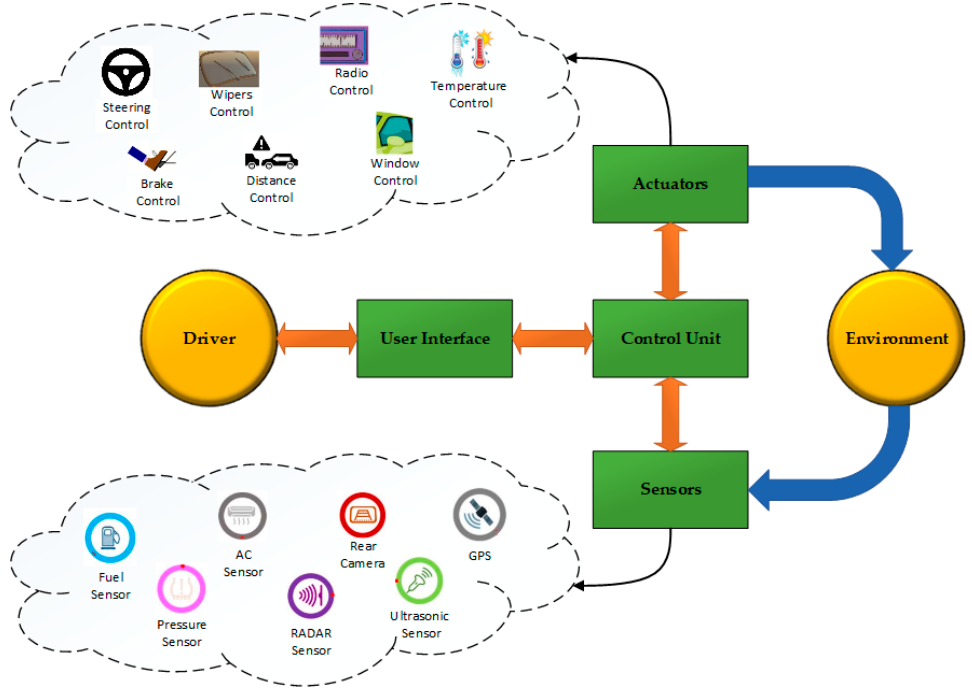
Figure 1. General safe driving conceptual model for smart cars.